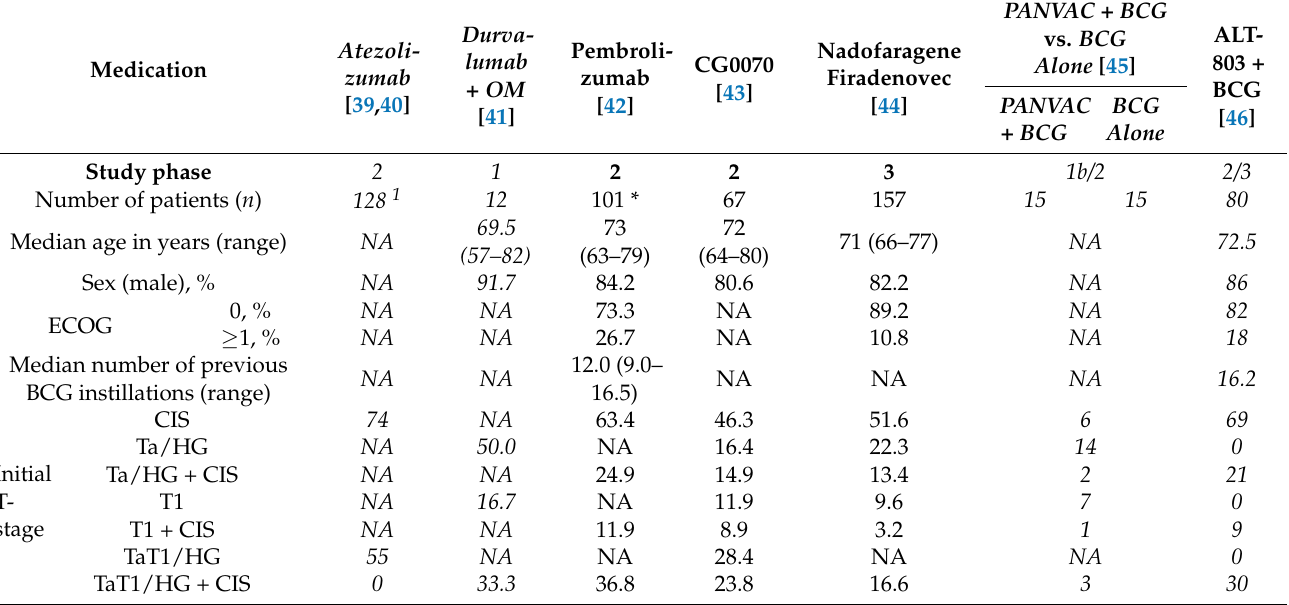
Table 1. Baseline characteristics of study participants (* received at least one of the study